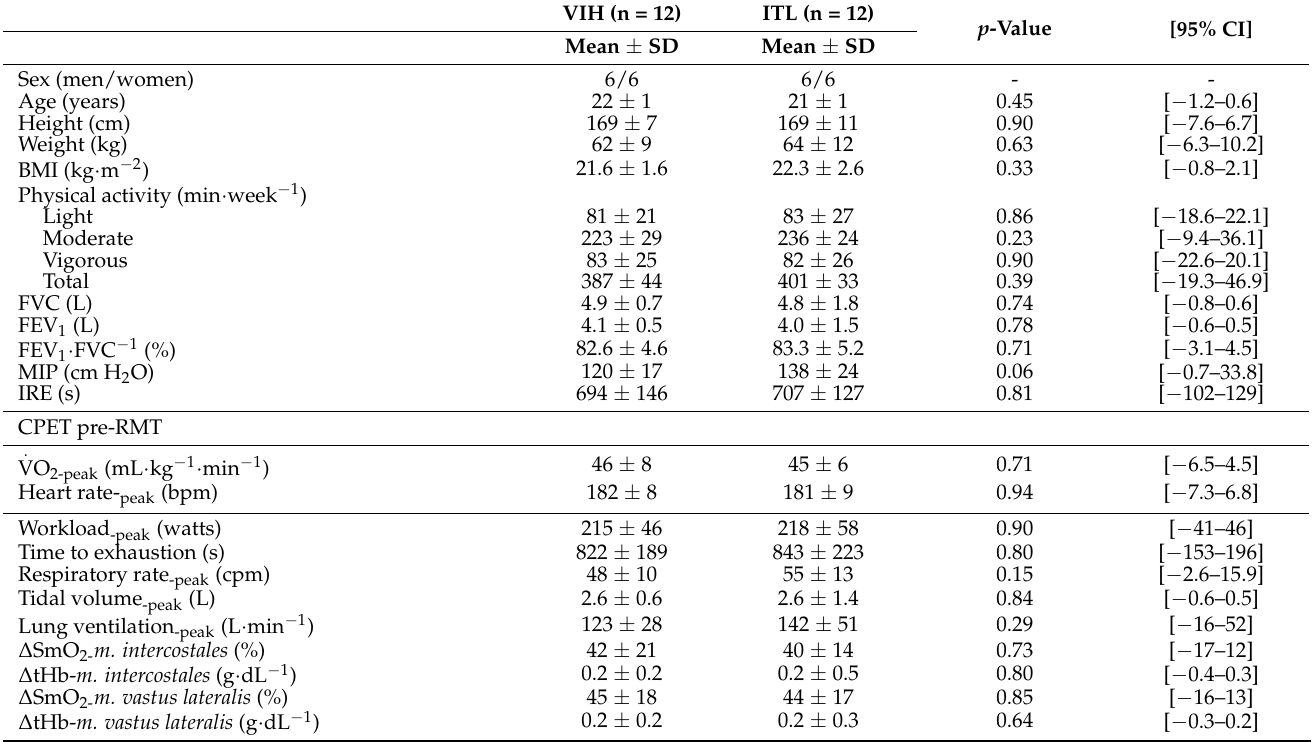
Table 1. Baseline